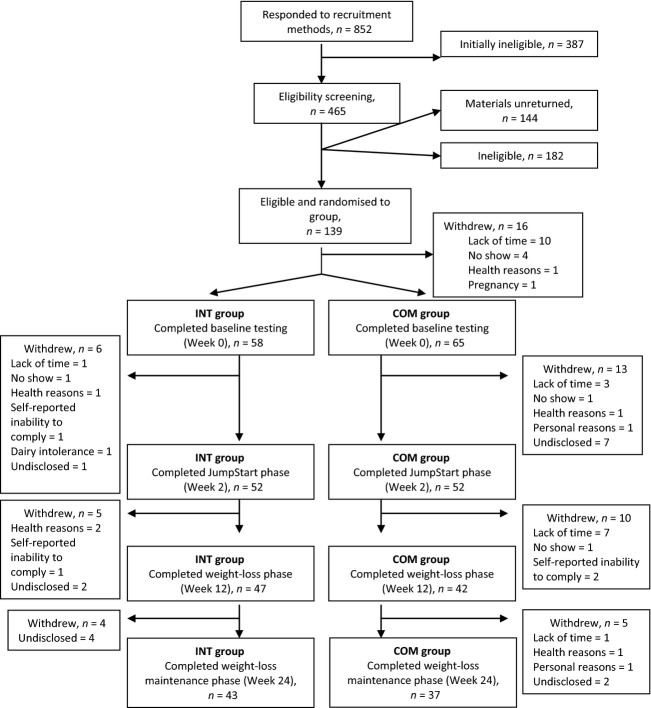
Diagram of recruitment, enrollment, randomization, and attrition of participants in a study examining changes in body composition and metabolic parameters in premenopausal women with overweight/obesity following an energy-reduced dietary pattern (ERD), including moderate protein and increased nonfat dairy intake(INT group) or an ERD with standard protein and standard nonfat dairy intake(COM group) combined with walking. Primary reasons for study withdrawal included lack of time (n = 22), undisclosed (n = 16), and no return for subsequent testing (n = 7).